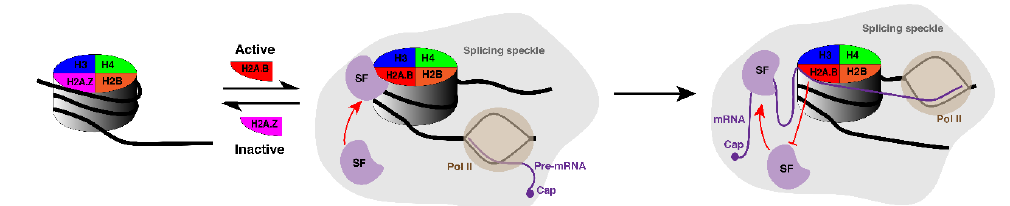
Figure 2. Model depicting the role of H2A.B in pre-mRNA splicing. Following the replacement of H2A.Z with H2A.B.3 to assemble active chromatin, H2A.B.3 directly recruits RNA processing factors from splicing speckles to an active gene. Upon transcriptional elongation and the synthesis of mRNA, H2A.B.3 binds and “holds” onto this RNA, thus releasing the splicing factors to facilitate the splicing